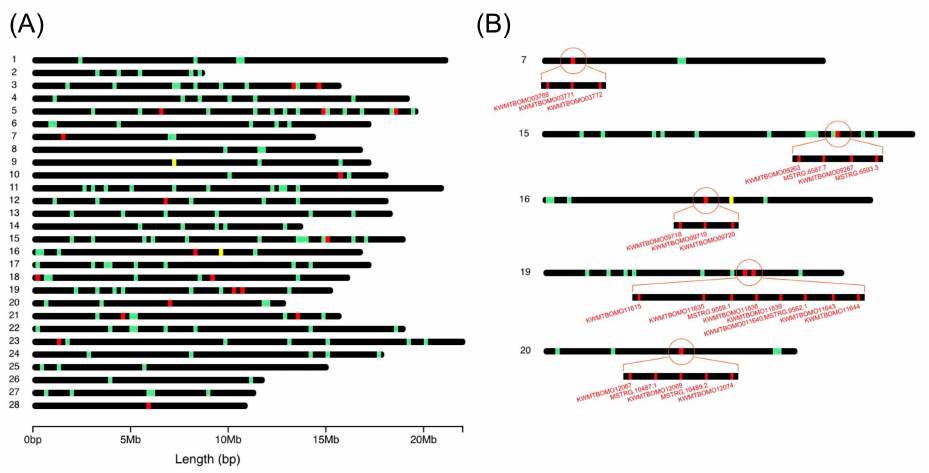
Figure 8. Genomic position of the transcripts strongly expressed in the MG only (red bar), in other than the MG (green bar), and commonly in the MG and other tissues (yellow bar). The top 50 strongly expressed transcripts are shown. The black bar indicates the chromosome. The number at the left side of each chromosome indicates the chromosomal number. ( A ) The genomic positions of all chromosomes. ( B ) The genomic positions of chromosomes 7, 15, 16, 19, and 20, in which tight clusters of strongly expressed transcripts in the MG are